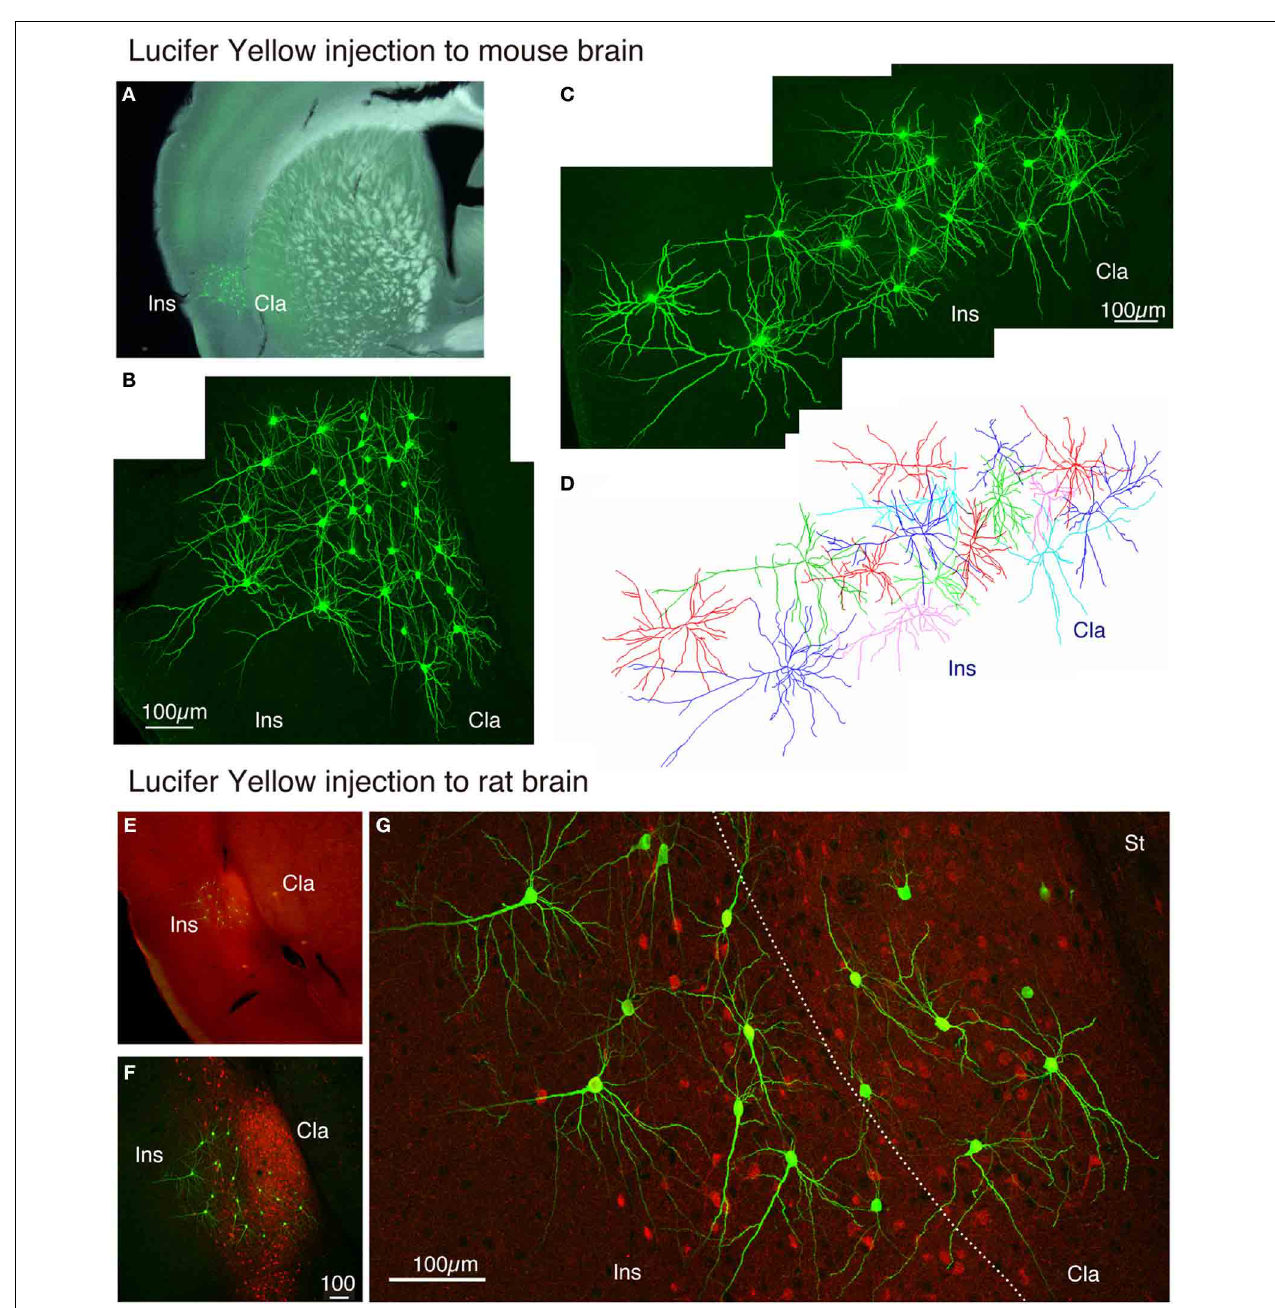
FIGURE 7 | Lucifer Yellow injection to the mouse and rat claustral neurons. (A) Dark field image of the mouse slice that received Lucifer Yellow injection to the insular/claustral region. The fluorescent image of the antibody-enhanced Lucifer Yellow-filled neurons is superimposed to indicate the location of clustered injection. (B) Maximal projection stacks of confocal sections for magnified view of the insular/claustral region of (A) . Note the meshwork of dendrites that cover the insular cortex and the claustrum. (C) Another injection into the mouse slice. The pia is to the left. (D) Reconstruction of the Lucifer Yellow injected neurons shown in (C) . Different cells are shown by different colors for better representation of each cell. (E) Merged view for latexin (red) and Lucifer